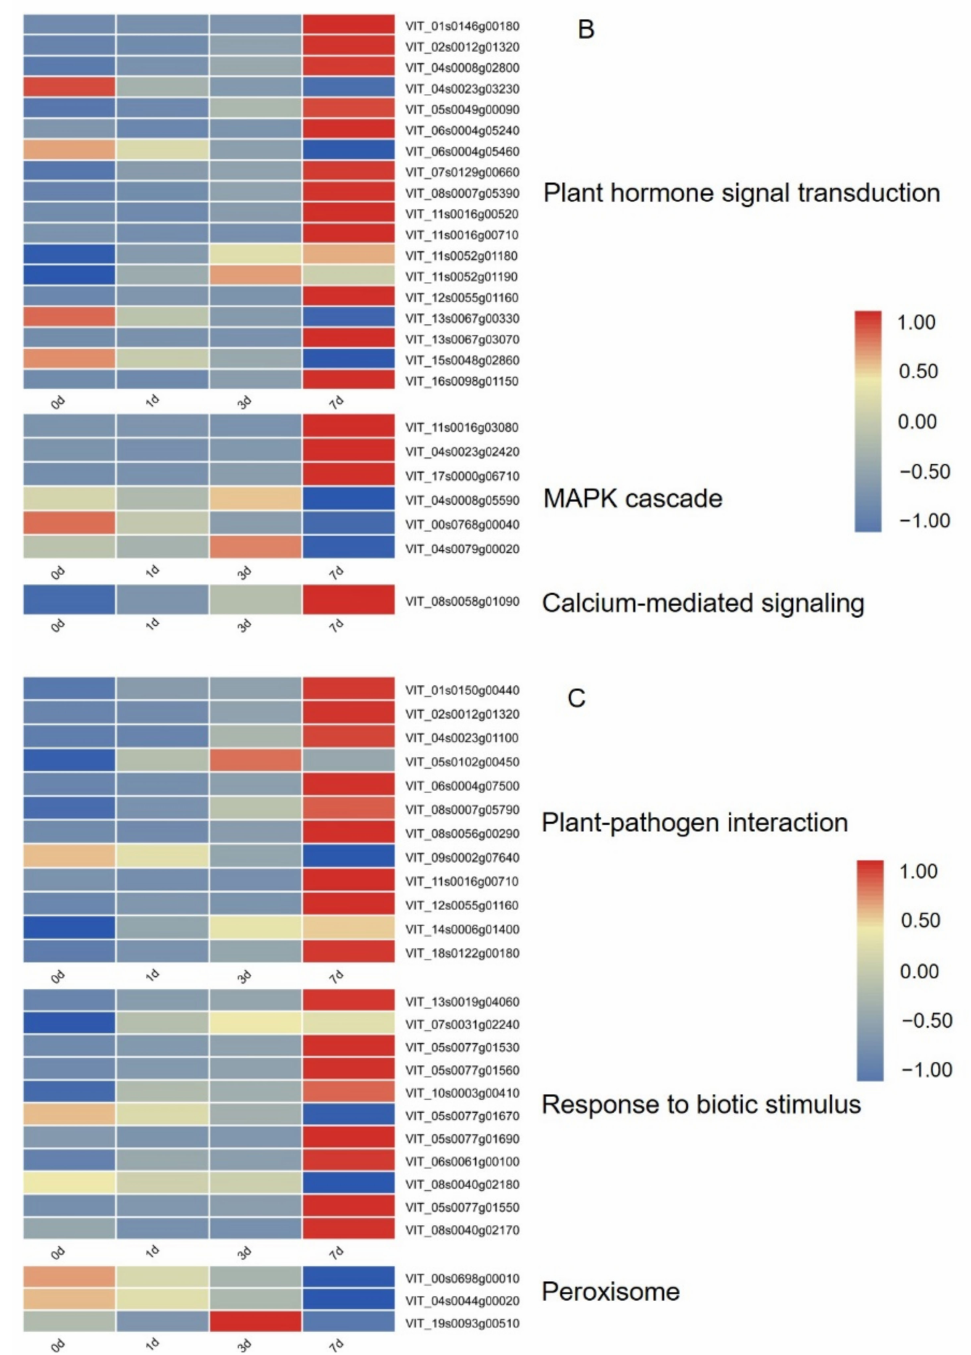
Figure 5. Differentially expressed genes in different pathways. ( A ) Expression profiles of primary metabolism genes in Vitis davidii Föex berries infected with Colletotrichum viniferum . ( B ) Expression profiles of signal transduction genes in Vitis davidii Föex berries infected with Colletotrichum viniferum. ( C ) Expression profiles of pathogen-resistance genes in Vitis davidii Föex berries infected with Col- letotrichum viniferum . Heat maps of genes were constructed with transcriptome quantitative data. The genes that increased and decreased are displayed in red and blue,